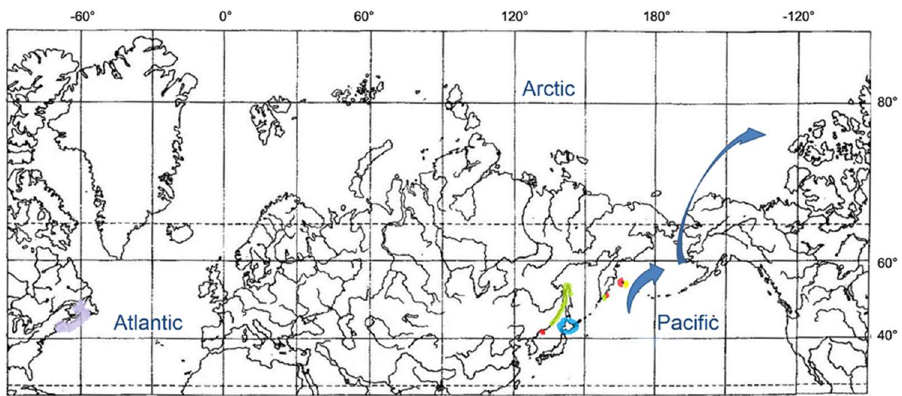
Figure 3. Distribution of “ L. grennitzkii ” group in the Atlantic: lilac line— L. inquilinus ; in the Pacific: red dots— L. grennitzkii , green line— L. kuznetsovi , blue line— L. miostomus , and yellow dot— L. mednius ; arrows show the most probable direction of the preglacial pathway.